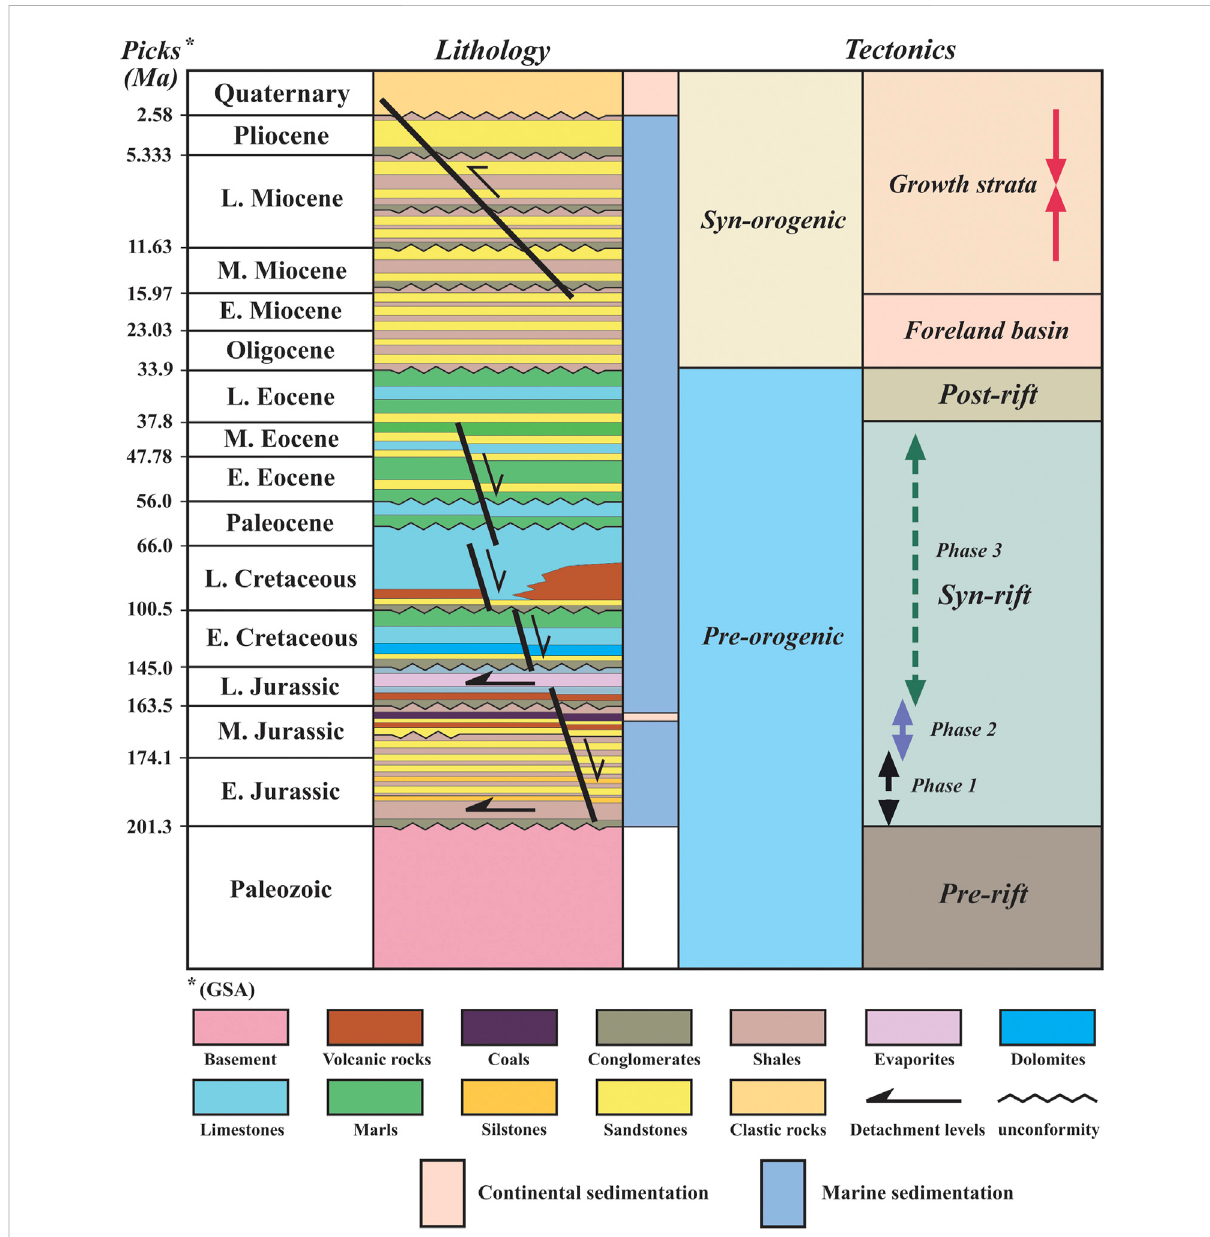
FIGURE 3 TectonostratigraphicchartoftheRionibasinandsurroundingarea(modi fi edfromAdamiaetal.,2010;Adamiaetal.,2011a,Adamiaetal.,2011b; Vincent et al., 2016, Tari et al., 2018; Alania et al.,